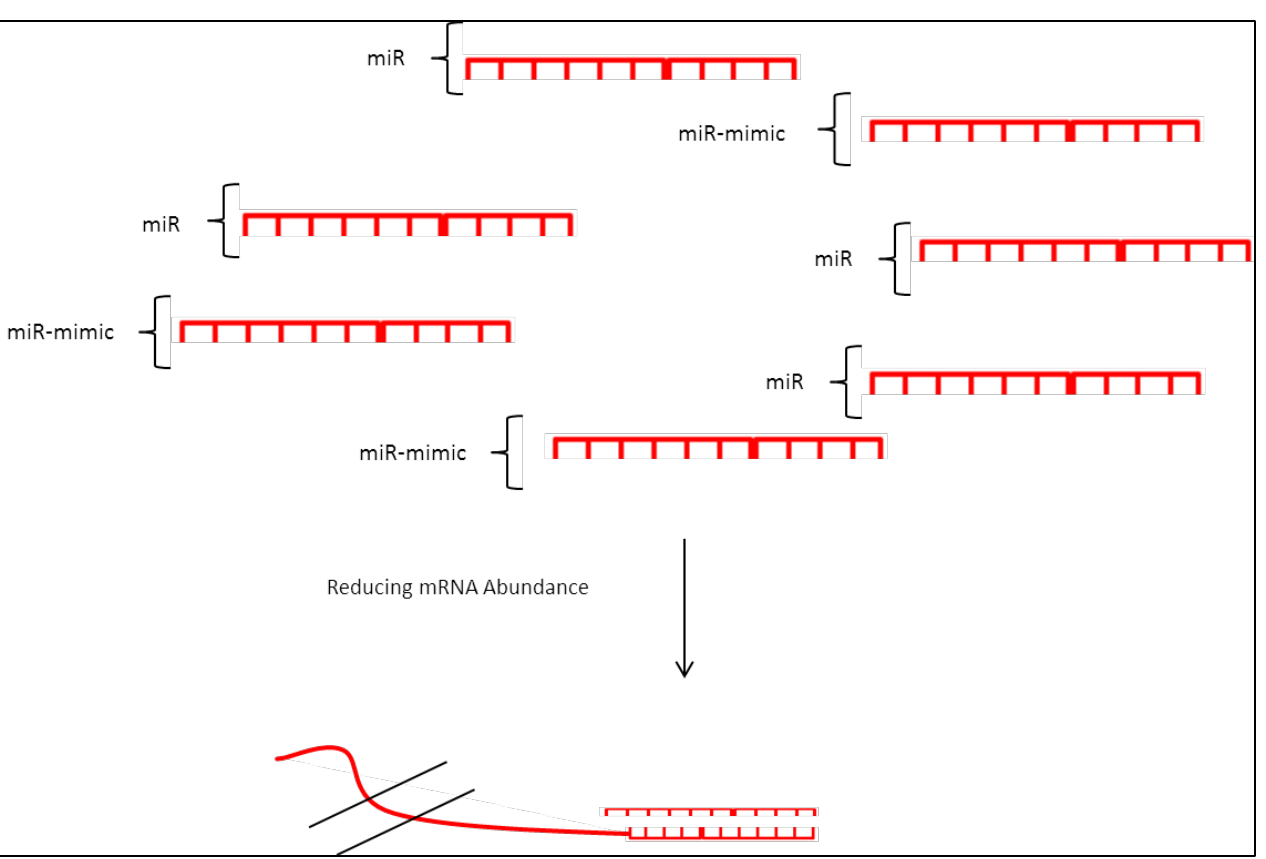
Figure 5. miRNA mimic uses short RNA sequence which mimics target miRNA bases sequence, this acts as a tool in inducing miRNA activity which would result in downregulation of target